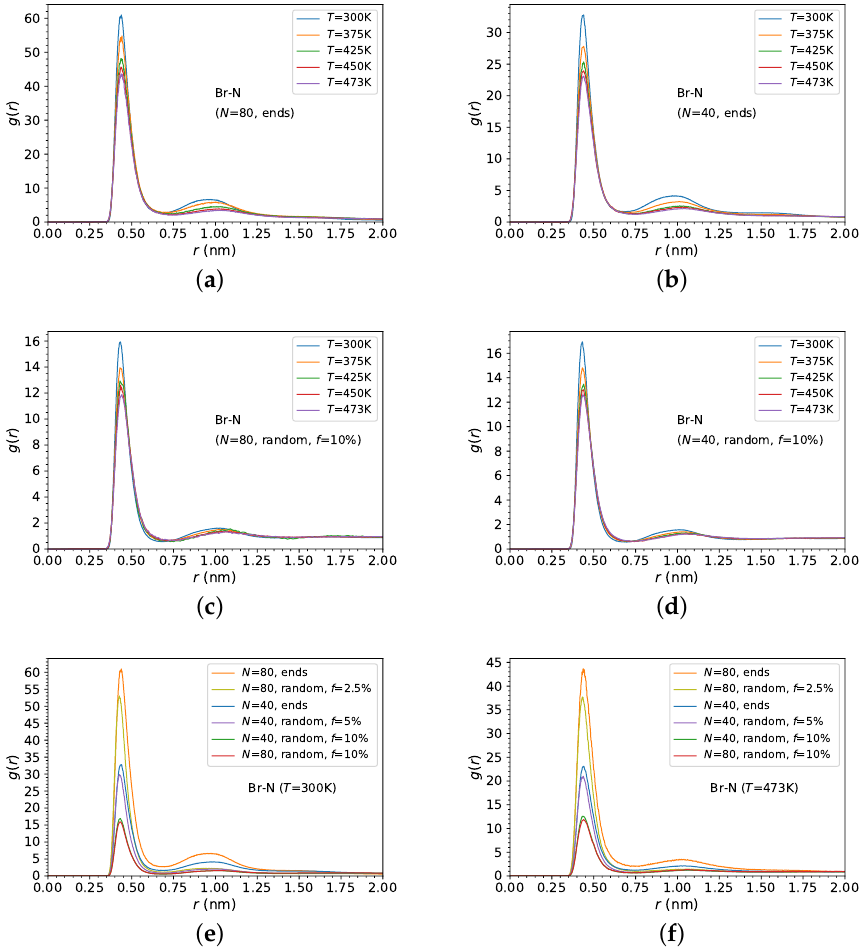
radial distribution function showing a distinct effect on both first and second coordination cells of ionic PDMS architectures and temperatures.